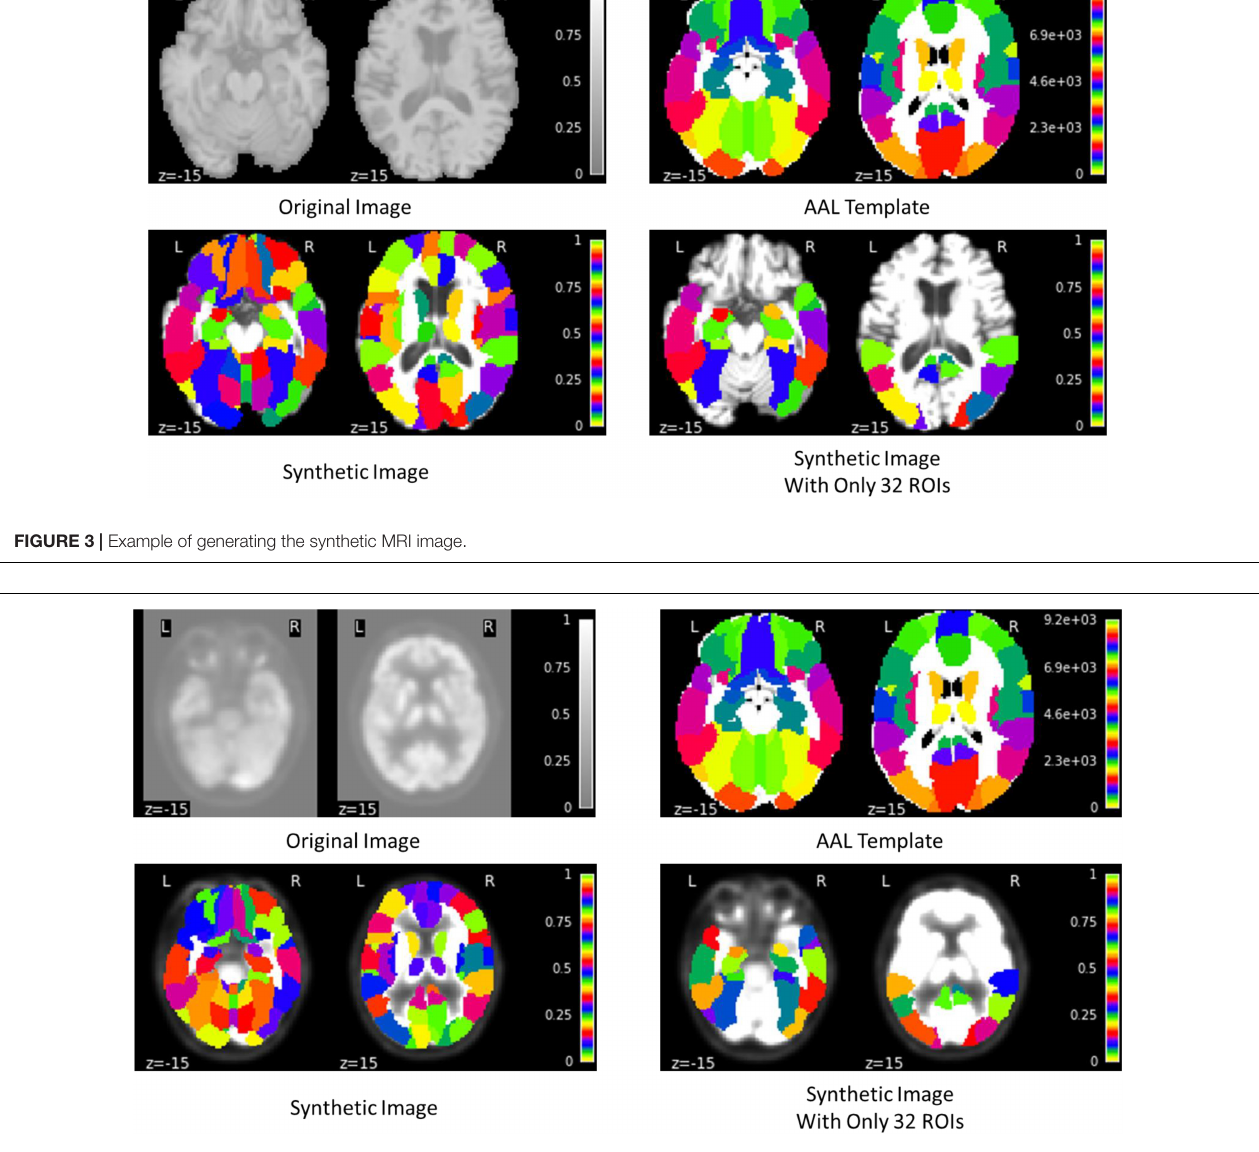
FIGURE 4 | Example of generating the synthetic PET